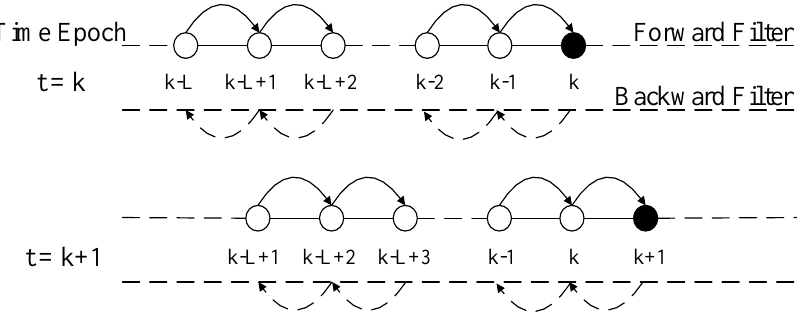
Figure 1. The process of the fixed-lag ensemble Kalman smoother (FLEnKS) algorithm.